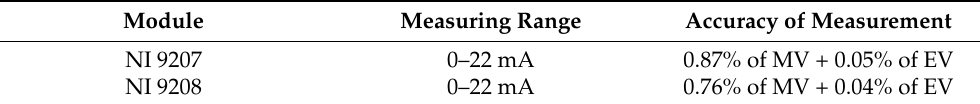
Table 4. Measuring range and accuracy of the signal conditioning